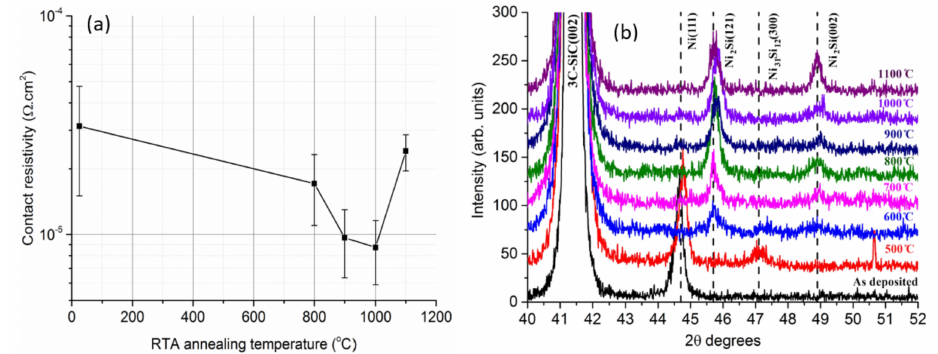
Figure 4. ( a ) Specific contact resistance dependence on the PMA temperature and, ( b ) XRD measure- ments of metal/3C-SiC (6 × 10 20 cm − 3 ) interface after various PMA temperatures indicating silicide formation. Contact was fabricated by depositing (Ti30 nm/Ni100 nm) on 5 × 10 20 cm − 3 N implanted